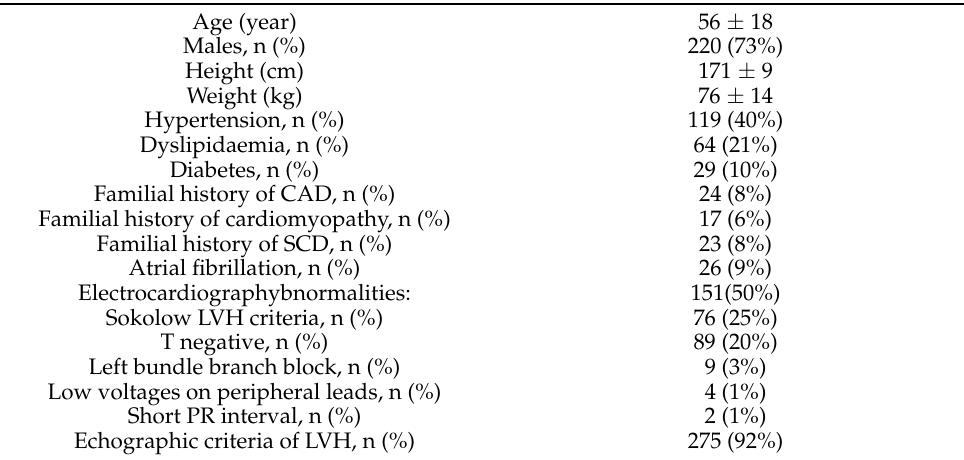
Table 1. Characteristics of the whole population (n = 300